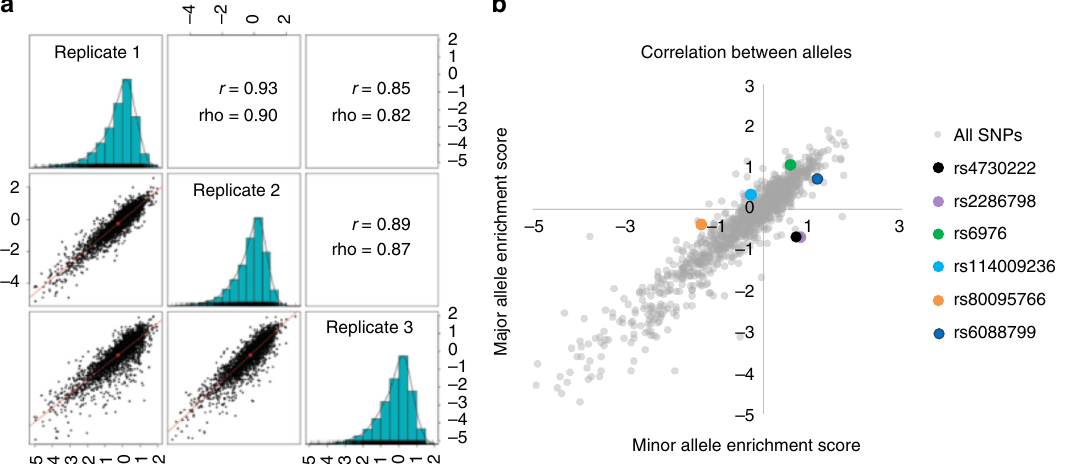
Fig. 2 Pairwise correlations between replicates and identi fi cation of alleles with differential regulatory activity. a Pairwise correlation of RNA/DNA ratios between three replicates. The lower left triangle shows pairwise scatter plots. The diagonal provides replicate names and the respective histogram of the RNA/DNA ratios for that replicate. The upper triangle provides Pearson (rho) and Spearman (r) correlation coef fi cients. b Scatter plot of the major versus minor allele for each SNP. Six SNPs with differential regulatory activity (indicated by colors in the legend) were identi fi ed using a Mann – Whitney U Test with an FDR of 10%. Source data are provided as a Source Data fi